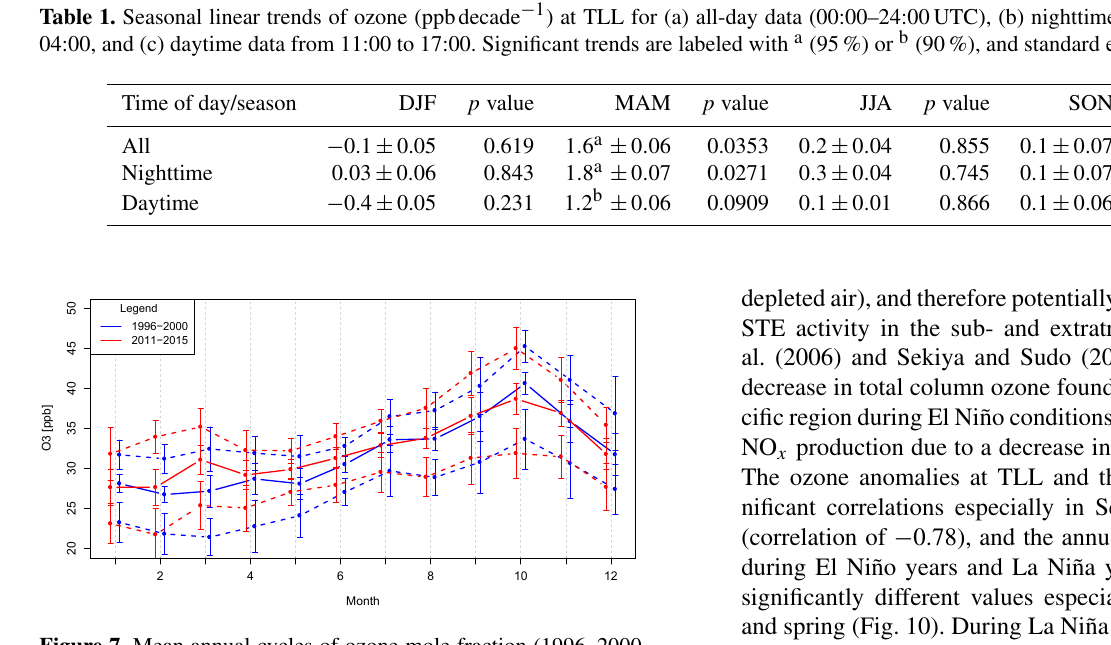
Figure 7. Mean annual cycles of ozone mole fraction (1996–2000 and 2011–2015) showing mean, upper 95th percentile, and lower 5th percentile. For better readability, the monthly means for both periods have been shifted by ± 6 days.